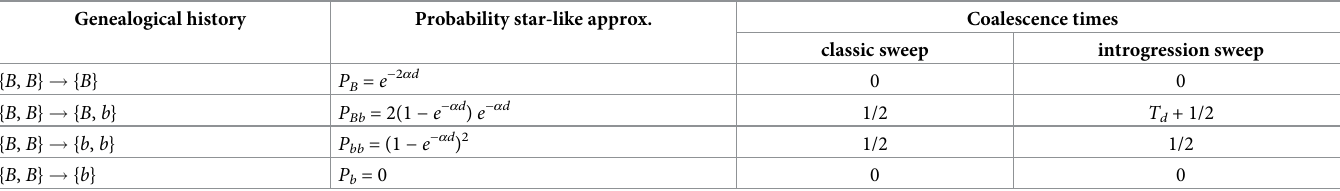
Table 1. Summary of the effects of